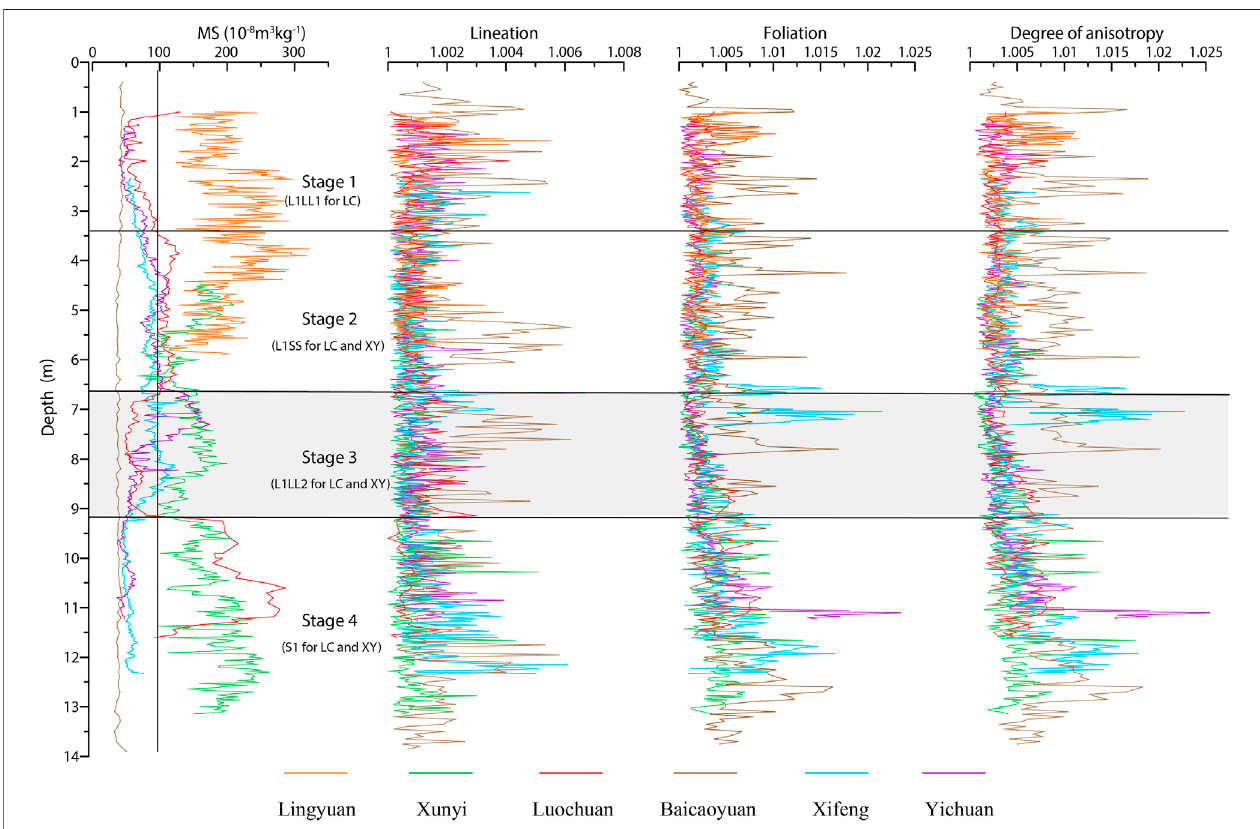
FIGURE7| Comparingthedepthvs.variationsofMS,L,F,anddegreeofanisotropy indifferentsections:LY(orange),XY(green),LC(red),BCY(brown),XF(blue), and YC (purple).